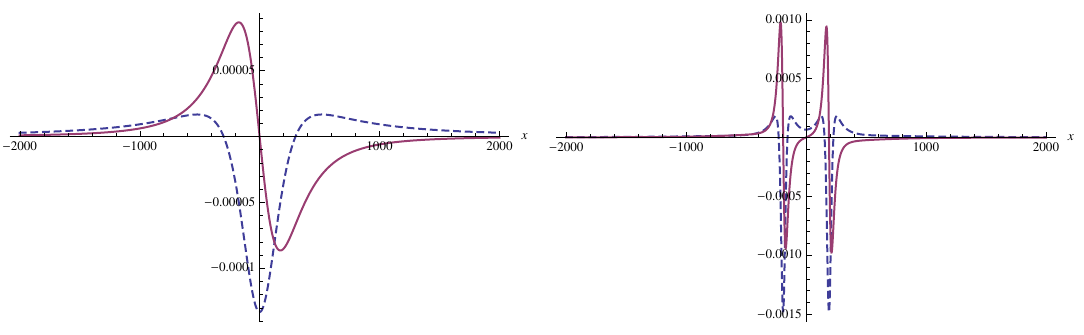
-symmetric sta- PT